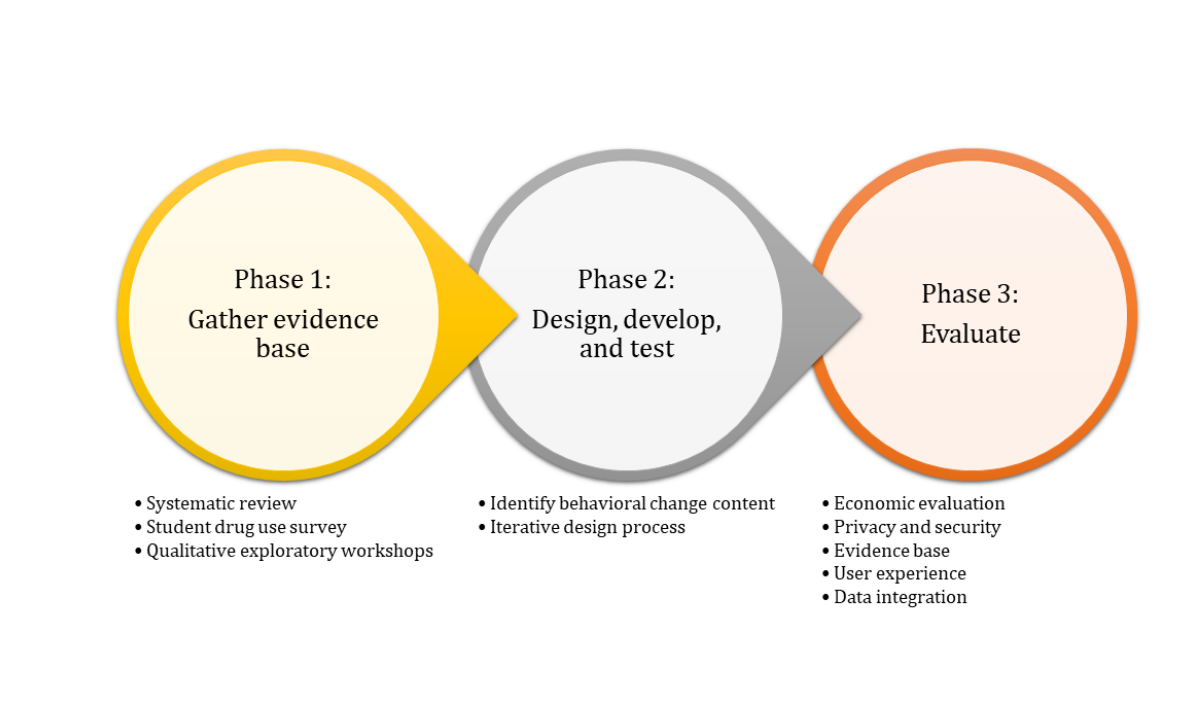
Figure 1. Objectives of the MyUSE (My Understanding of Substance use Experiences)